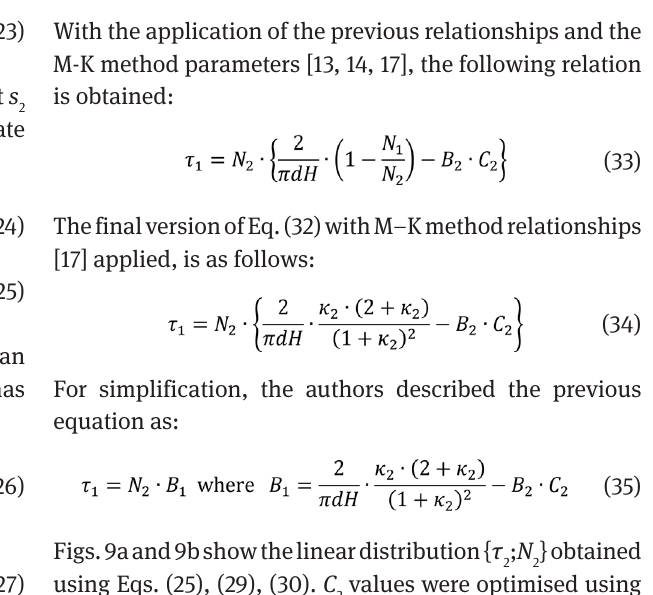
; N } obtained 2 2 values were optimised using 2 ; N } obtained with Eq. 1 2